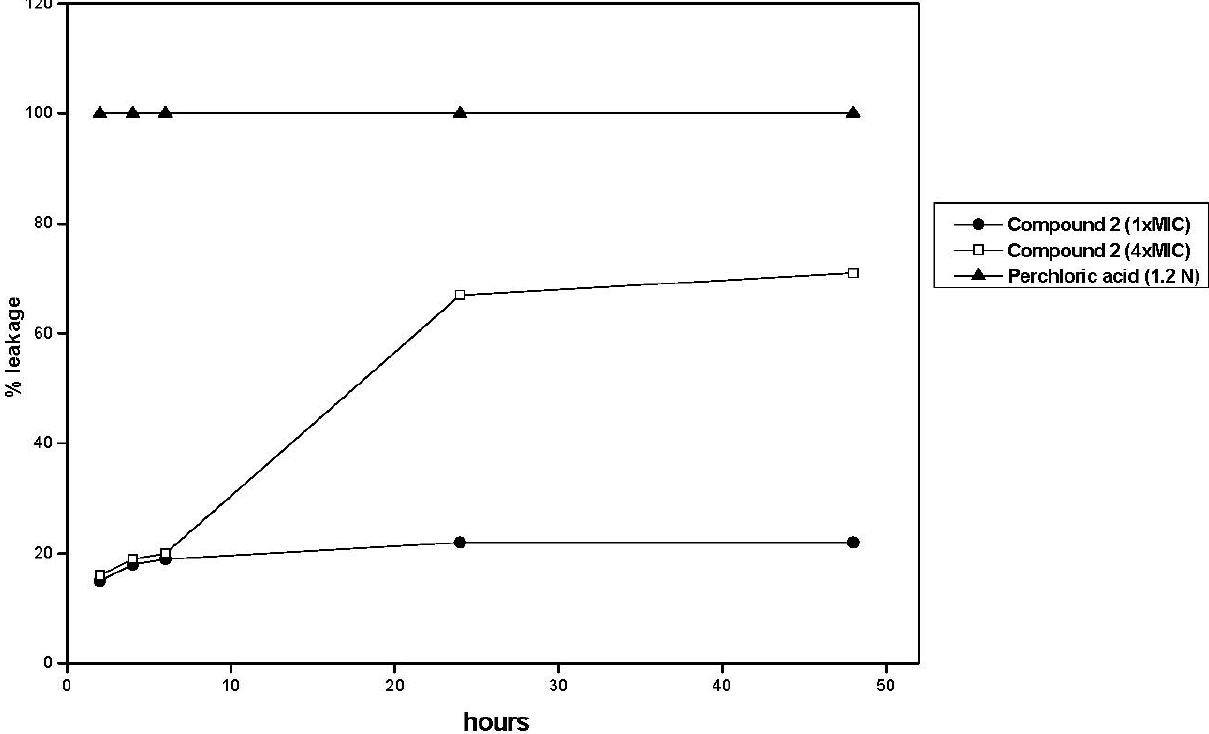
Figure 3. Release of 260-UV absorbing materials from cells of C. albicans ATCC 10231 incubated (2–48 h) with 1× and 4× MFC of 6-NO